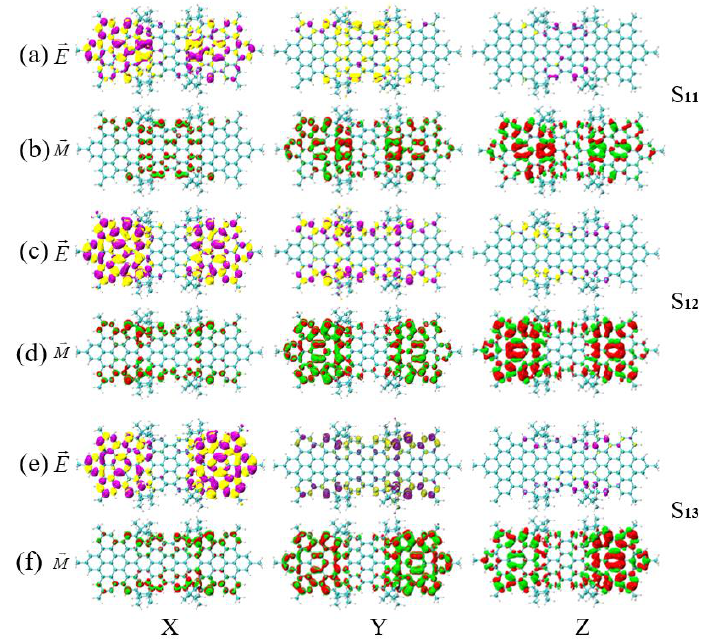
Figure 10. The TEDM and TMDM of S11, S12 and S13 of symmetrical diastereomers (PPMM). ( a , b ) are the TEDM and TMDM of S11 in the x/y/z direction; ( c , d ) are the TEDM and TMDM of S12 in the x/y/z direction; ( e , f ) are the TEDM and TMDM of S13 in the x/y/z direction. The letters E and M in the figure indicate the TEDM and TMDM of the molecule, respectively.